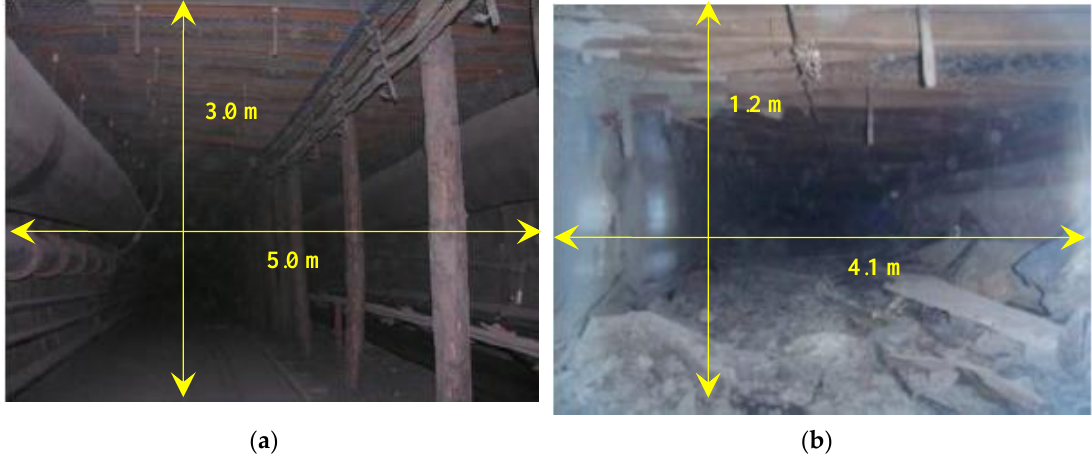
Figure 5. Profile of the RGSG before the first longwall panel mining ( a ) and profile of the RGSG when the first longwall face stopped moving ( b ).